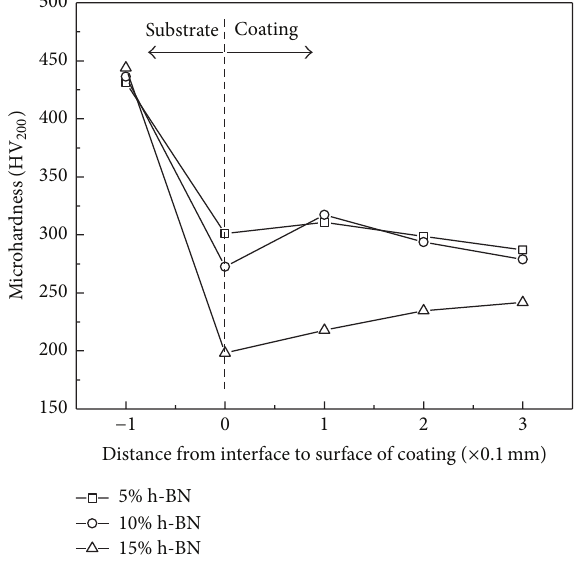
Figure 5: Microhardness of cross-sectional coating.